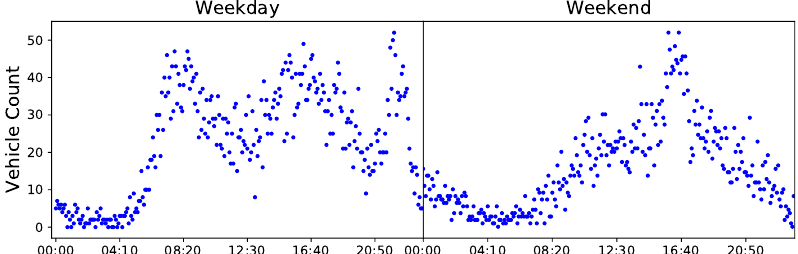
Figure 3. Scatter plots for vehicular density counts on an average game day on a weekday ( left ) and weekend ( right ). The first two distinct peaks on the weekday represent the morning and afternoon traffic peaks respectively, whereas the sharp peaks around 23:00 on the weekday and on 16:30 on the weekend represent traffic caused by fans leaving the stadium after a baseball